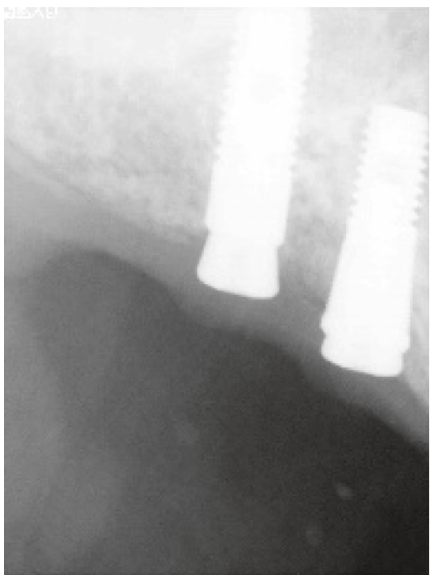
Figure 4: Astra ∗ implants (4.5 × 11, 4.0 × 11) replacing teeth 16 and 17.